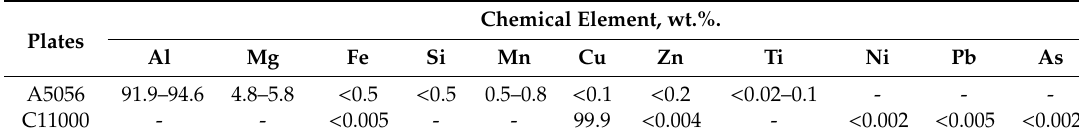
Table 1. Chemical composition of A5056 and C11000